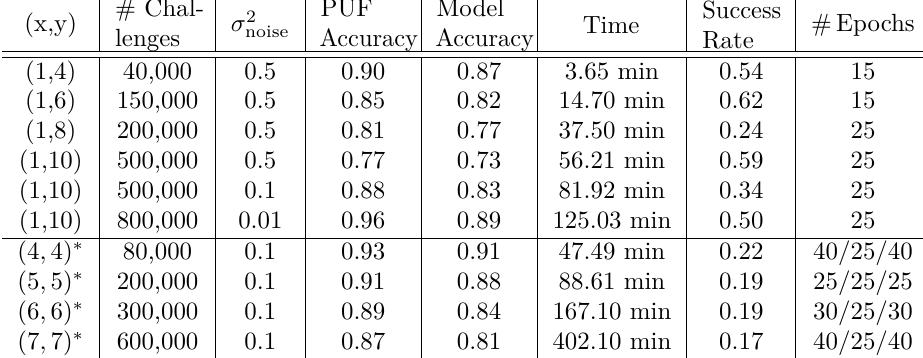
Table 3: Simulation results for the combined LR-reliability attack on iPUFs. For each instance size, 20 PUF instances were attacked with eight trials each. Instances marked with an asterisks were attacked with the multi-pass approach, all other instances with the single-pass approach. Note that we state the number of unique challenges. Each challenge was queried ten times to get a reliability estimate. All single-pass attacks used a single thread, while multi-pass runs were run on two threads.